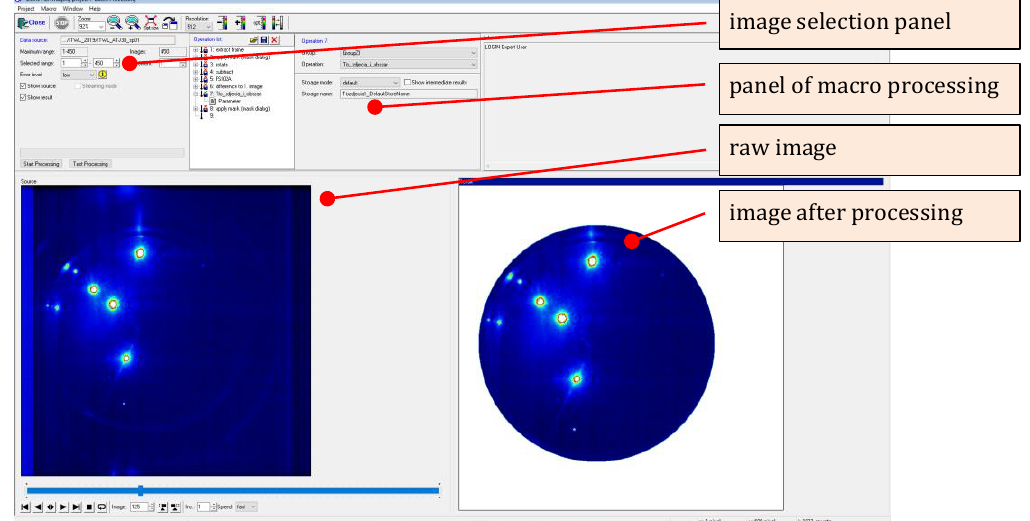
Figure 13. Software for the image analysis. The sequence of the autoignition spots pertains to the images with the dwell time of dt = 2.5 ms (every 10th image). The analysis was initiated from the 65th image (the first autoignition spot appeared there). This denotes the time of 65 × 0.2 ms = 13 ms from the start of the falling curve of the camera-controlling signal. The point in time, from which the autoignition spots were analyzed, was marked with a second vertical green line in Figure 14. The first line denotes the time when the camera was initiated.